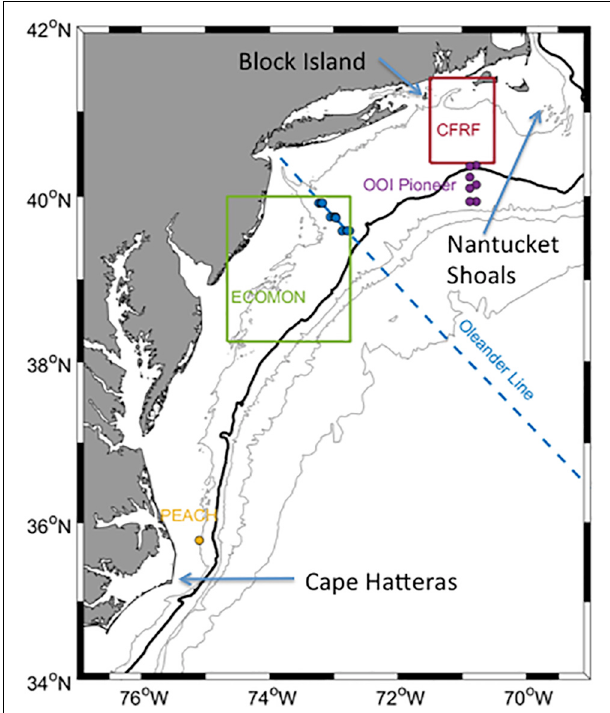
FIGURE 1 | A map of the Middle Atlantic Bight showing the locations of the primary data sources used in the analysis. The Commercial Fisheries Research Foundation (CFRF)/WHOI Shelf Research Fleet operational area is denoted by the red box south of New England. Moorings from the OOI Pioneer Array are indicated by the purple circles. The region comprising the ECOMON profiles from February 2017 is denoted by the green rectangle. The blue dashed line indicates the path of the CMV Oleander, with the XBT stations used marked with blue circles. The B1 mooring from the PEACH mooring array is denoted by the orange circle just north of Cape Hatteras. The cross-shelf hydrographic transect from PEACH in April 2017 was at the same latitude as the B1 mooring. The 40, 100 m (bold line), 1000, 2000, and 3000 m isobaths are indicated by the contour lines